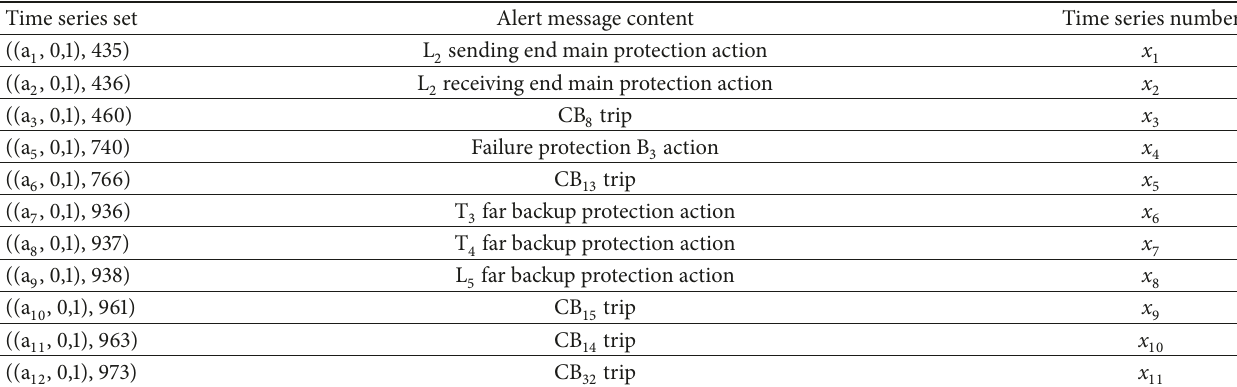
Table 5: Actual alarm information.